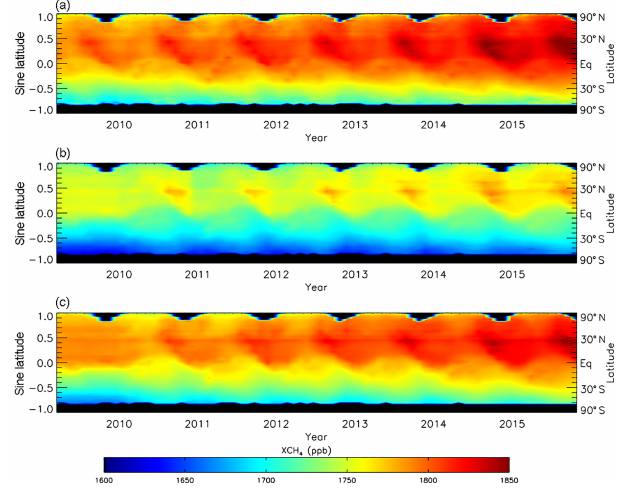
Figure 3. (a) Zonally averaged monthly mean XCH 4 volume mix- ing ratio (ppb) from GOSAT between April 2009 and December 2015 plotted against the sine of latitude, for which black denotes missing values. (b, c) Same as (a) but for TOMCAT simulations with prior and posterior emissions estimates, respectively. GOSAT averaging kernels are applied to model